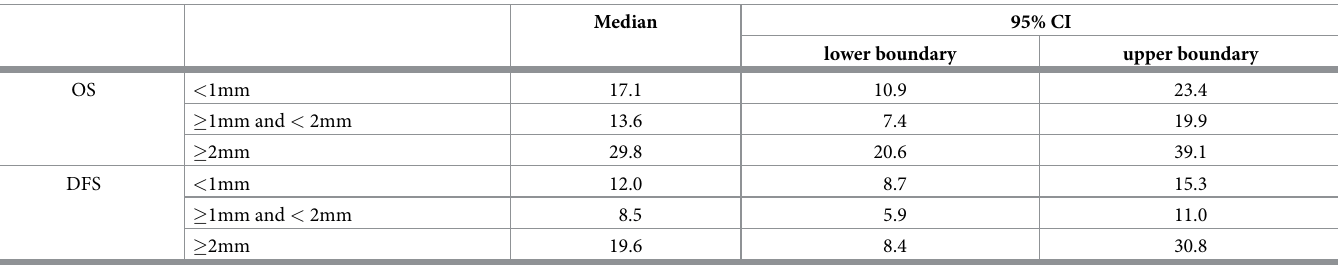
Table 3. Overall survival (OS) and disease-free survival (DFS) as a function of medial resection margin clearance. Median 95% CI lower boundary upper